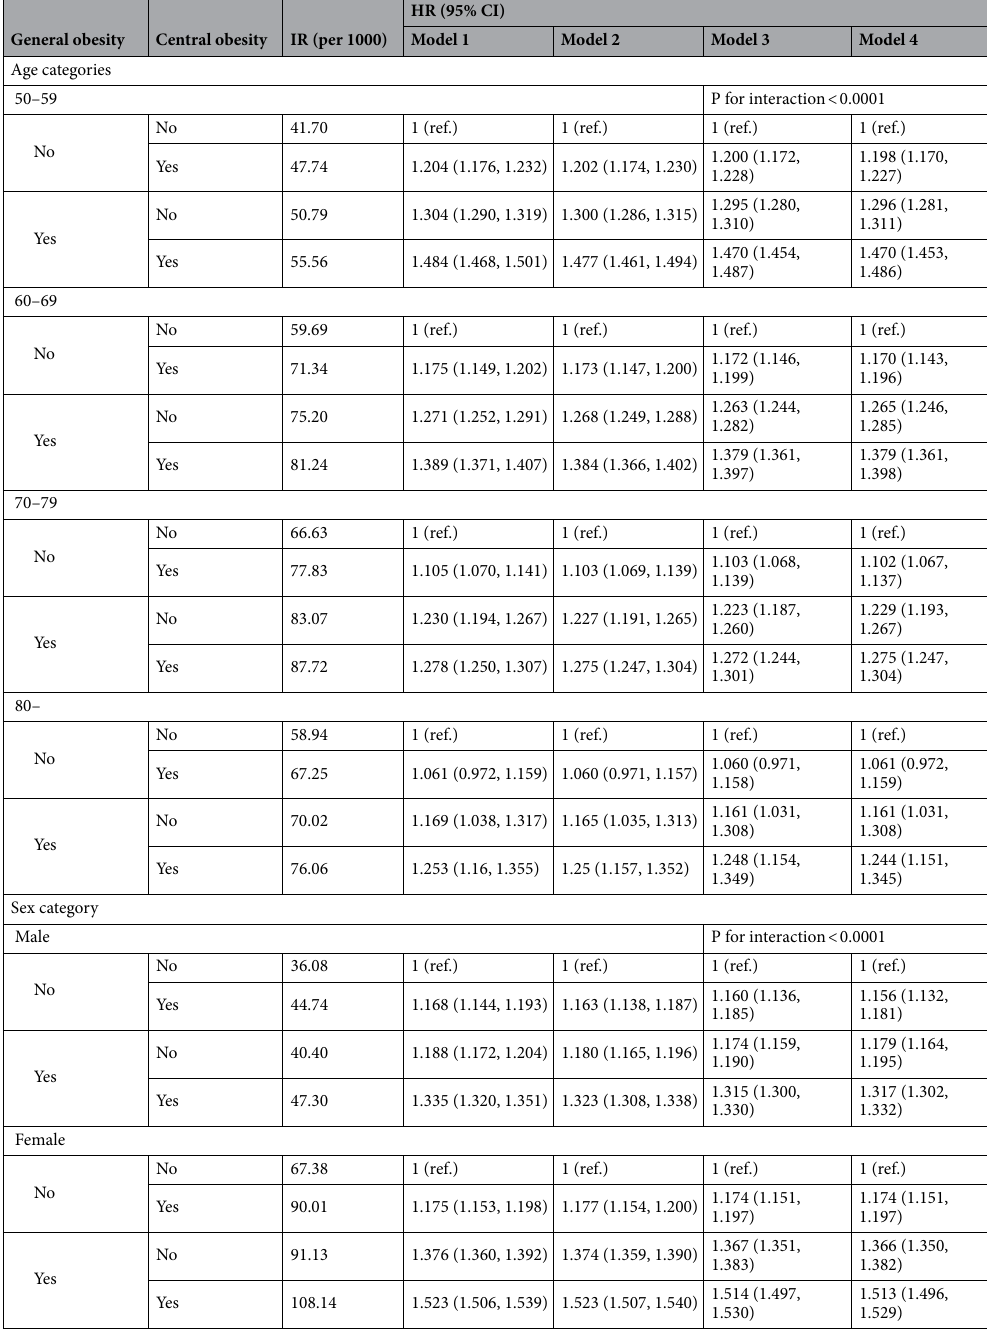
Table 4. Incidence rate and hazard ratio for the risk of knee OA of the general obesity and/or central obesity composition according to age and sex. Model 1 was adjusted for age, sex. Model 2 was adjusted for age, sex, income, smoking, alcohol intake and regular exercises. Model 3 was adjusted for age, sex, income, smoking, alcohol intake, regular exercises, diabetes, hypertension and dyslipidemia. Model 4 was adjusted for age, sex, income, smoking, alcohol intake, regular exercises, diabetes, hypertension, dyslipidemia, cancer, end-stage renal disease, chronic obstructive pulmonary disease, stroke, liver cirrhosis, hear failure, dementia and chronic kidney disease. HR hazard ratio, CI confidence interval, OA osteoarthritis, IR incidence